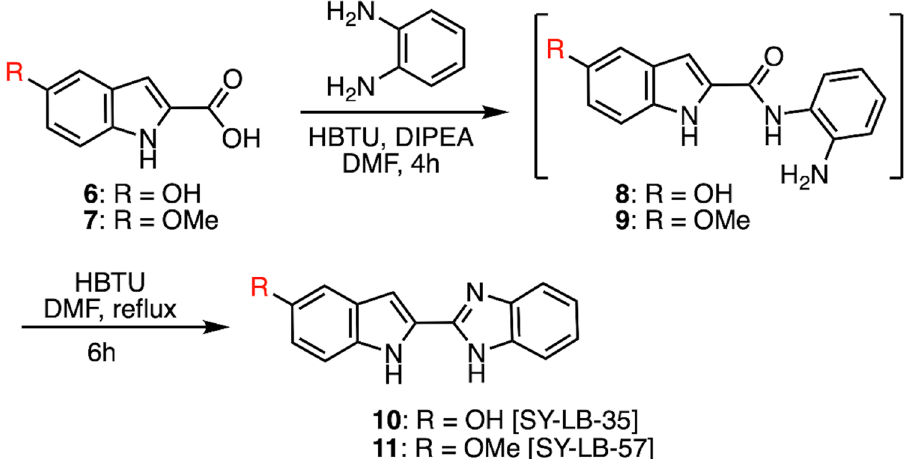
Figure 2. Synthesis and structures of indolyl-benzimidazoles. The figure describes the synthetic scheme used to prepare the two indolyl-benzimidazoles. The carboxylic acid (compounds 6 and 7 ) was converted after 4 h to the amide (compounds 8 and 9 ) in the first step, and the amide was subsequently converted after 6 h into the benzimidazole (compounds 10 and 11 ) via a one-pot